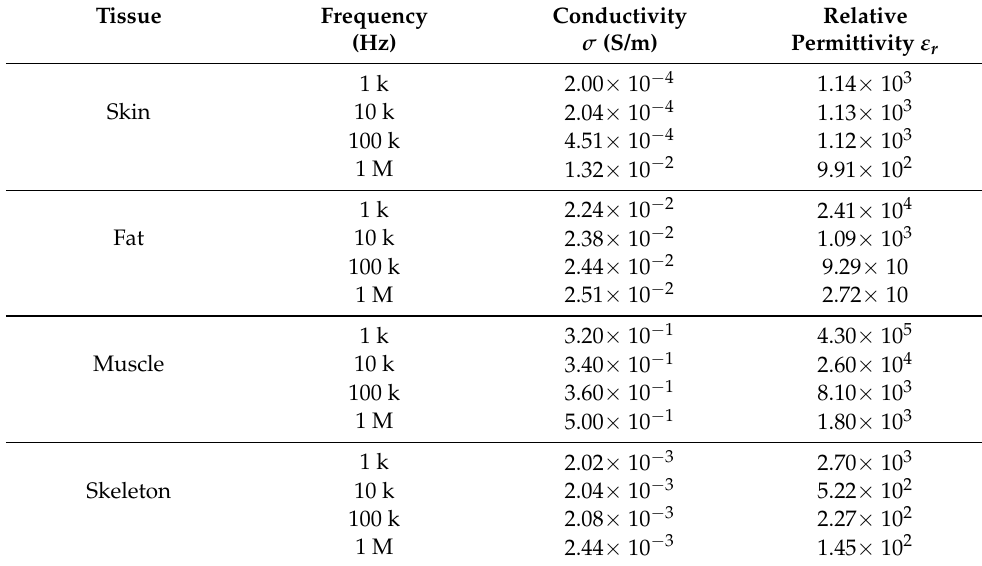
Table 1. The tissue’s electrical parameters.